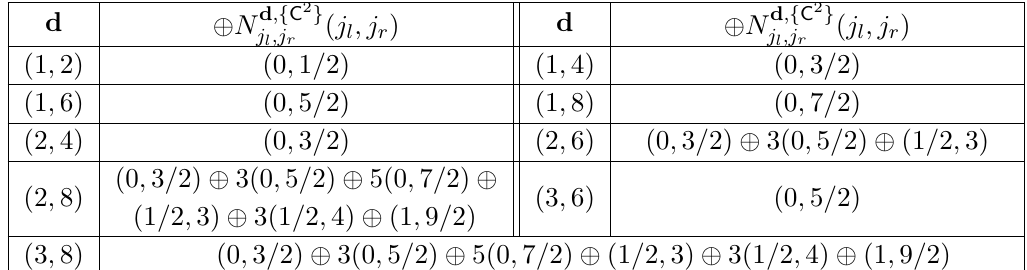
for the curve class d 1 m 0 + d 2 φ with d 1 ≤ 3 BPS , { C 2 }